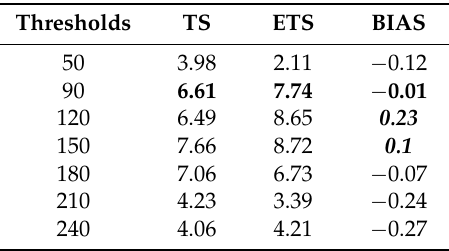
Table 2. Differences of skill scores between Merged and ERA